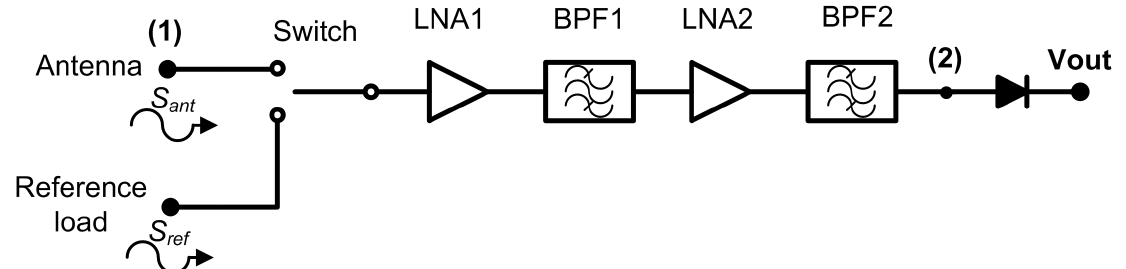
Figure 1. A typical radiometer configuration for medical applications using a switched Dicke